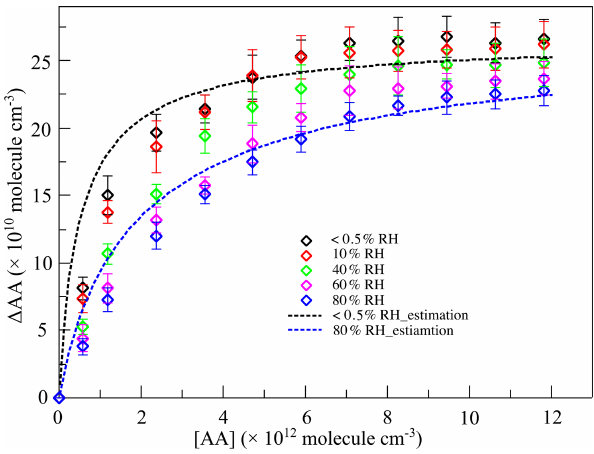
Figure 2. The variations of the consumption of acetic acid ( (cid:49) AA) with the concentration of acetic acid ([AA]) at different relative hu- midity (RH) levels in the first-generation oxidation. Scatters: mea- sured (cid:49) AA; black line: estimated (cid:49) AA at < 0.5%RH; blue line: estimated (cid:49) AA at